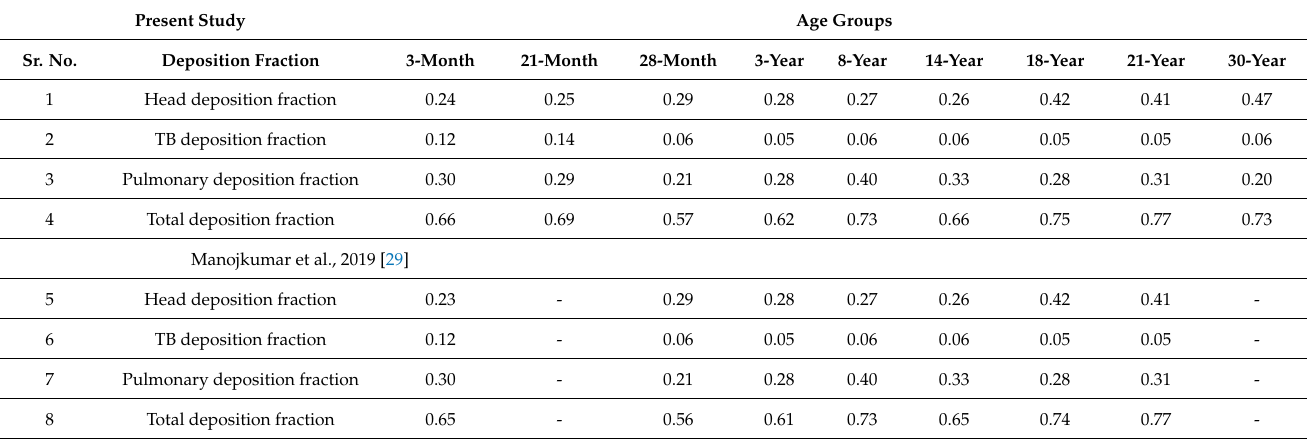
Table 5. Comparative analysis of PM 2.5 deposition fraction for different age